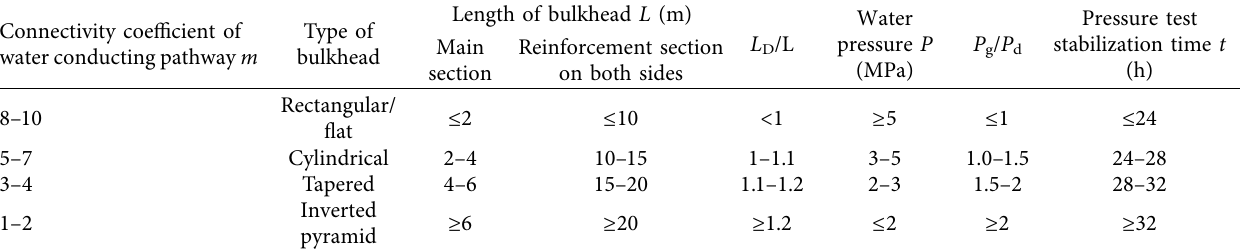
Table 2: Connectivity coefficients of water conducting pathway of interface between bulkhead and surrounding rock. Connectivity coefficient of water conducting pathway